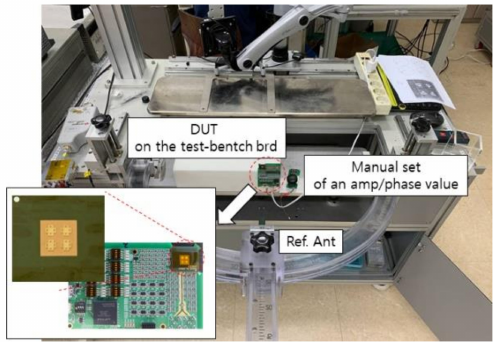
Figure 12. Measurement environment of the manufactured package.